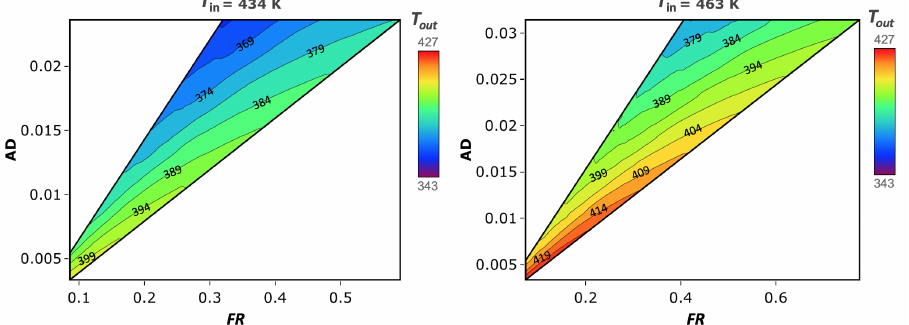
Figure 7. Contour plots of different DS volume sections at constant T in